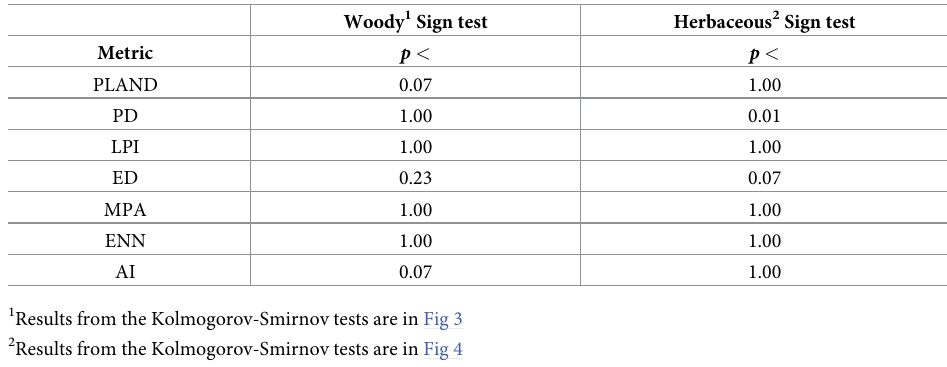
Table 2. Results of the sign tests from woody and herbaceous comparisons of ocelot-vehicle collision sites and crossing structures. P-values are relative to ocelot-vehicle collision